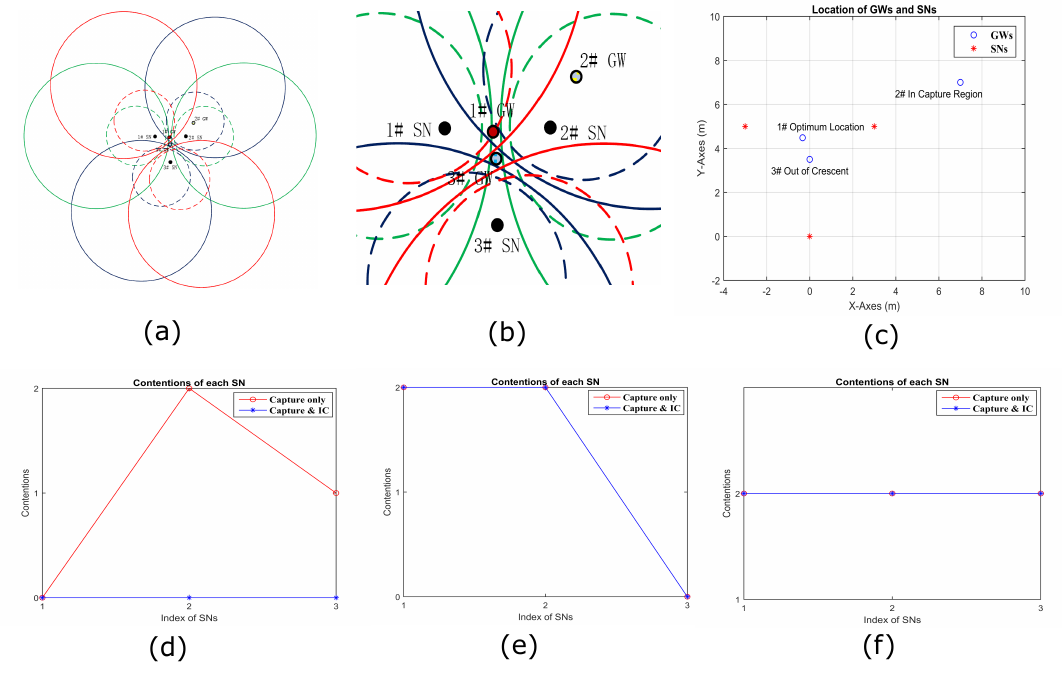
Figure 10. Contentions of each SN when a GW is placed at different locations. 1 (cid:93) GW is at the location by WBG placement, 2 (cid:93) GW is at the location of capture circle only and 3 (cid:93) GW is at location of out of any crescentm as shown in ( a , b ) by zooming in. ( c ) The coordinate location of SNs and GWs in different strategy. ( d – f ) The contention of each SN with three cases of the GW placement,